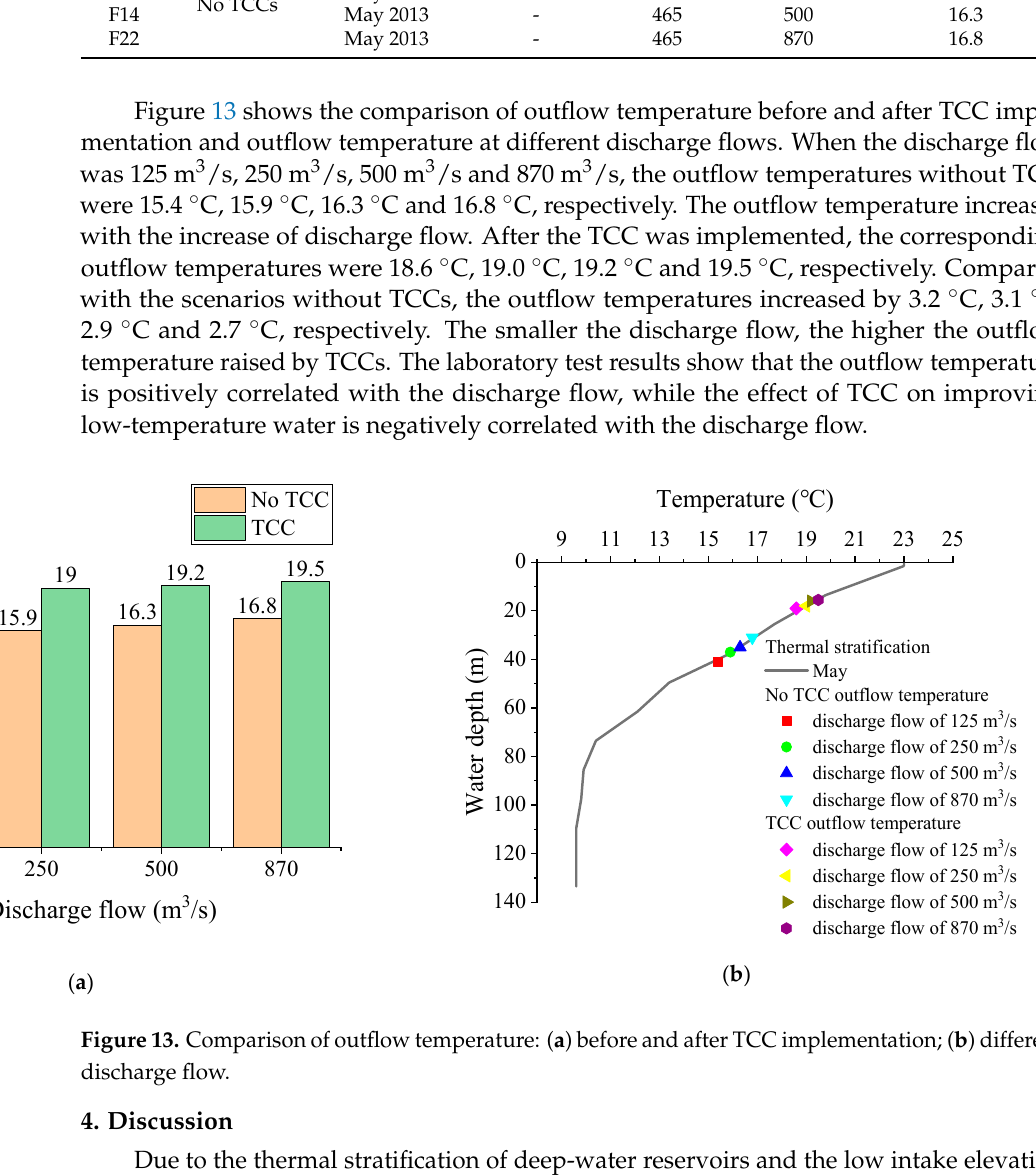
15 of 18 Figure 12. Comparison of outflow temperature: ( a ) before and after TCC implementation; ( b ) dif- ferent water level. 3.5. Discharge Flow Discharge flow is one of the important parameters affecting the flow field. To study the effect of discharge flow on outflow temperature, four discharge flows of 125 m 3 /s, 250 m 3 /s, 500 m 3 /s and 870 m 3 /s are considered. Other impact parameters remain unchanged and are set as follows: thermal stratification in May, flow height of 30 m, and water level